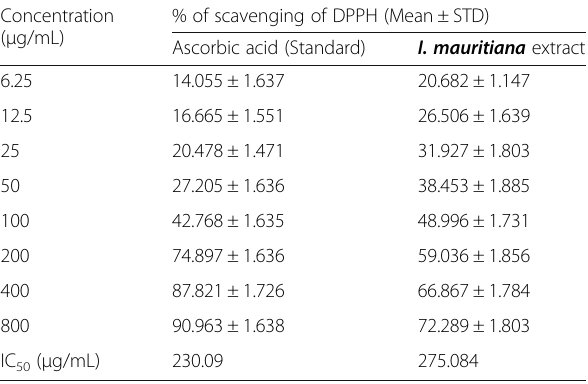
Table 2 DPPH free radical scavenging activity of ascorbic acid and I. mauritiana extract Concentration ( μ g/mL)